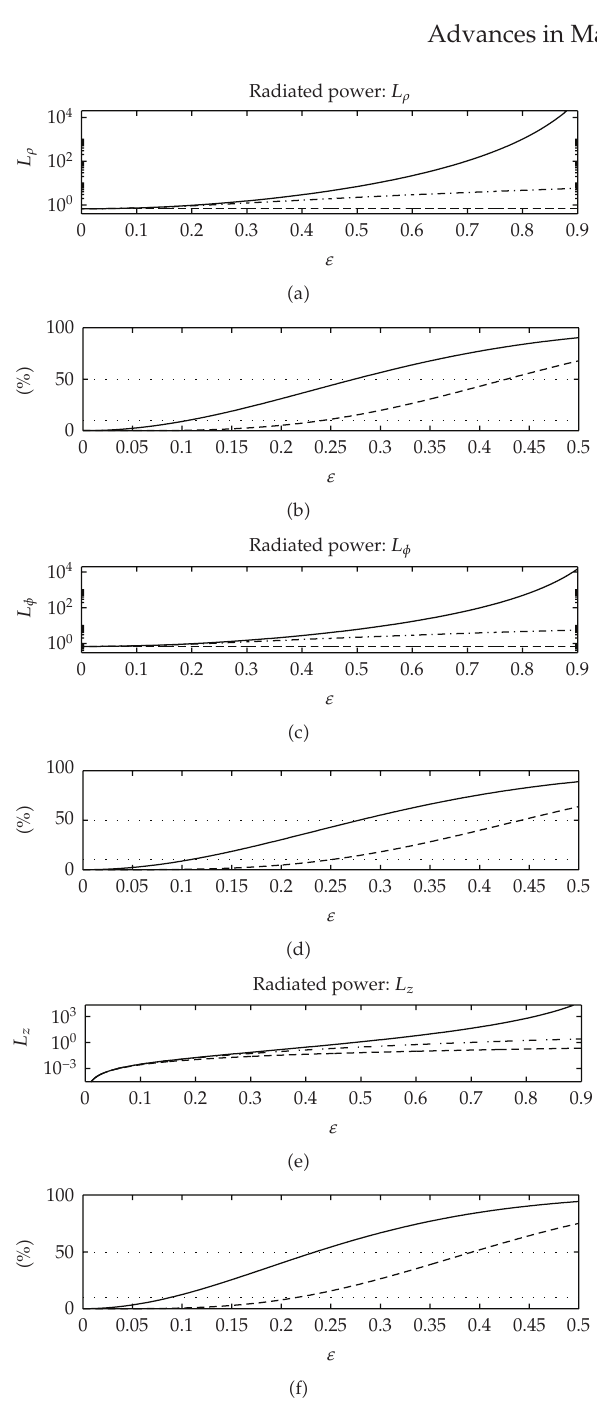
Figure 2: Comparison of the exact and approximate values for the three components of the function L . In panels 1, 3, and 5, the solid lines show the (cid:2) numerically calculated (cid:3) exact functions L ρ , L φ , and L z , respectively, and the dashed and dash-dot lines show the approximations F 0 and F 0 (cid:10) F 1 , respectively. All function values are normalized to Ω 4 /c 3 . In panels 2, 4, and 6, the relative deviation (cid:2) in percent (cid:3) from the exact function values is shown for the approximations L 0 (cid:2) solid lines (cid:3) and L 0 (cid:10) L 1 (cid:2) dashed lines (cid:3) , respectively. The two dotted lines mark deviations of 10% and